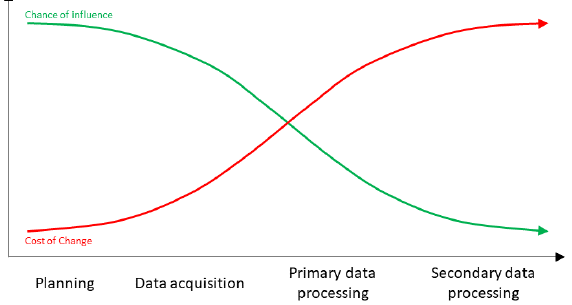
Figure 1. Typical stages of a terrestrial laser (TLS) scanning